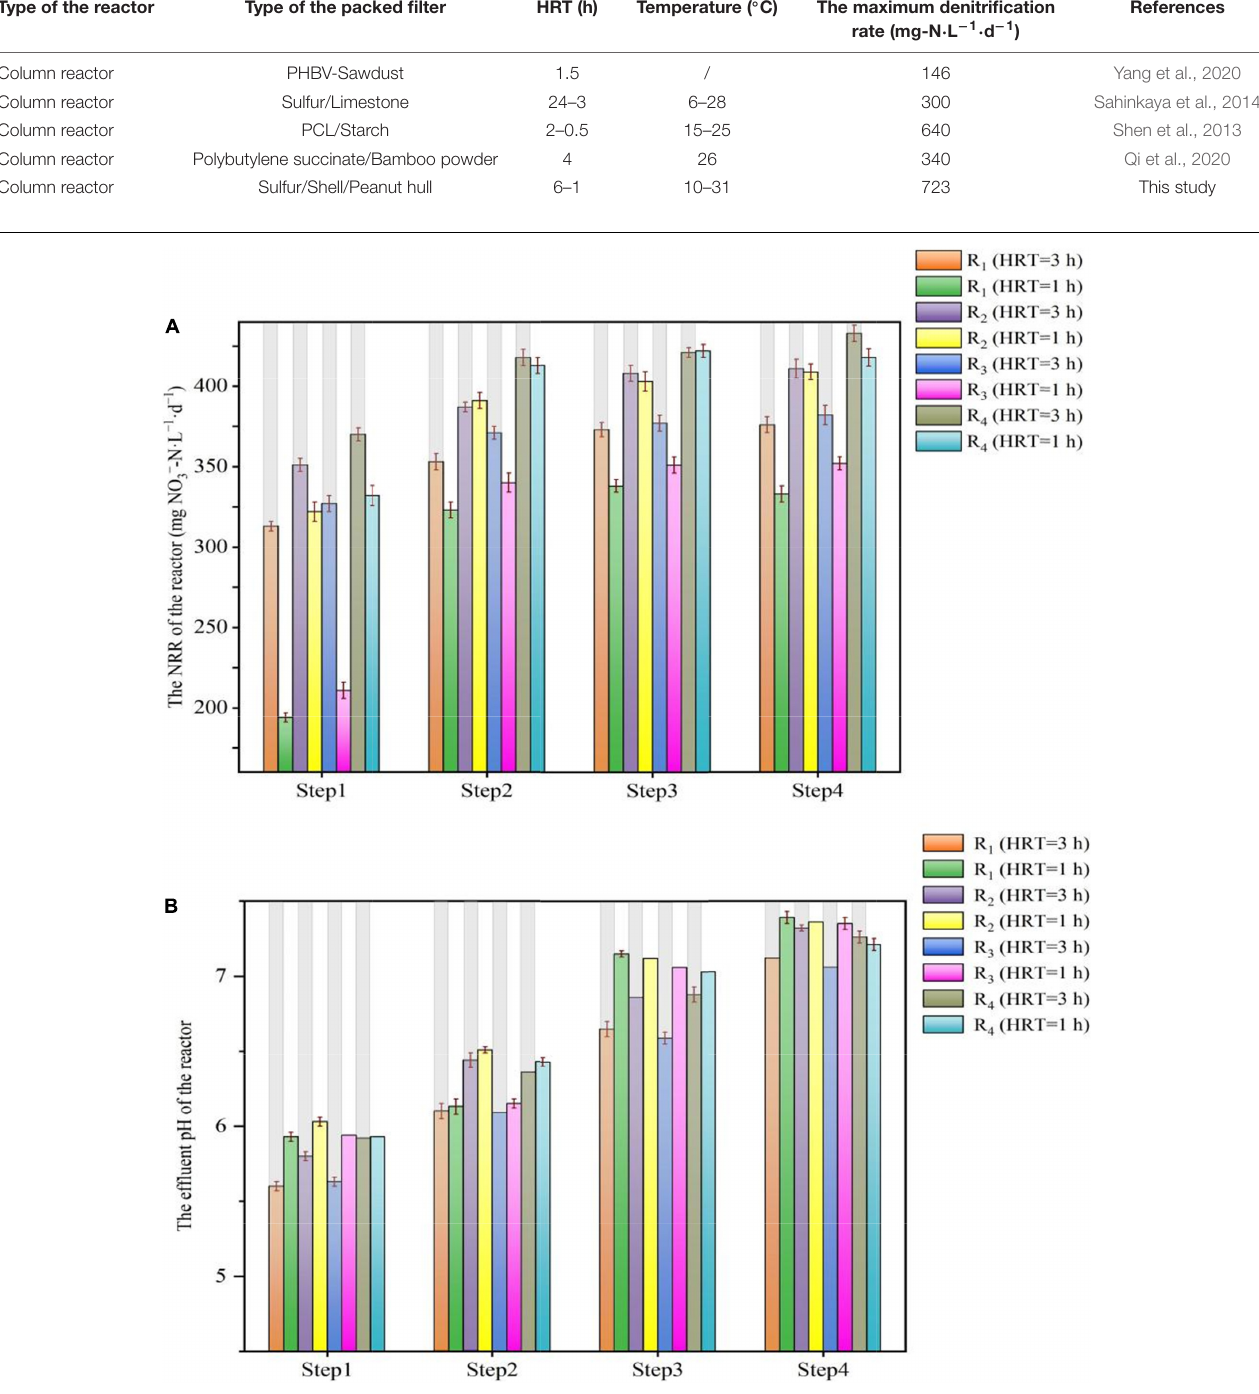
TABLE 3 | Comparison of studies on packed-bed denitrification.